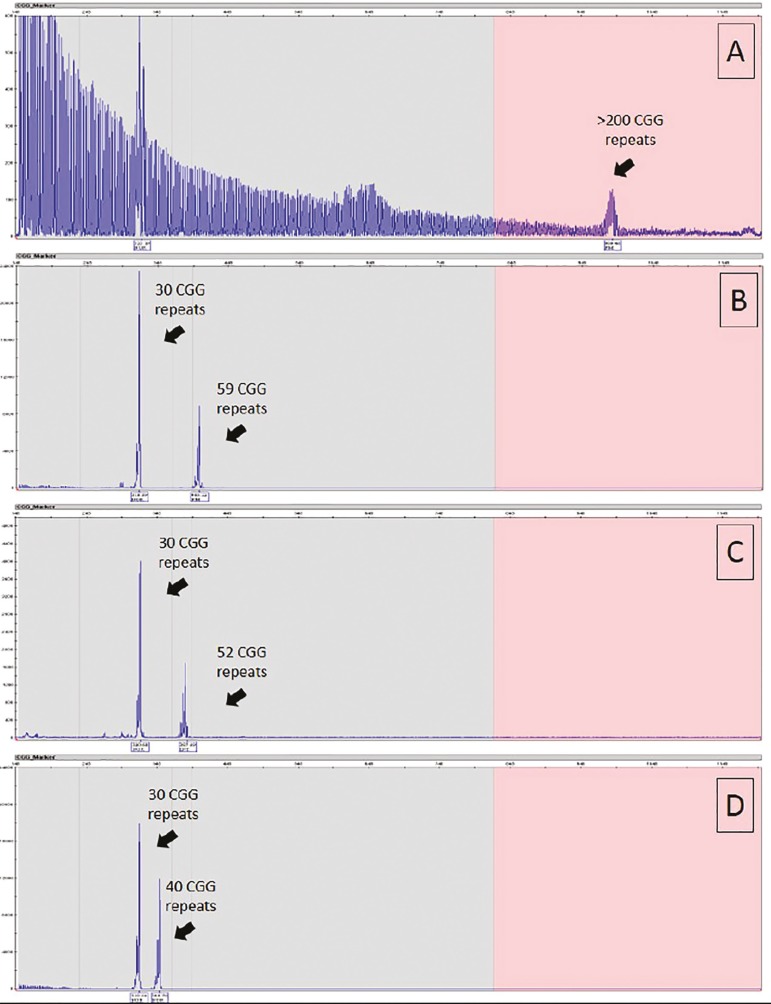
Fragile X testing. The number of CGG repeats was determined by Tripled Repeat Primed PCR amplification of the 5' untranslated region of the FMR1 gene followed by capillary electrophoresis (AmplideX FMR1 PCR Kit, Asuragen, Austin, TX, USA). (A): Patient with a full mutation, confirming the diagnosis of Fragile X syndrome; (B): Patient with two alleles with 30 and 59 CGG repeats, suggestive of premutation; (C): Patient with two alleles with 30 and 52 CGG repeats, which corresponds to an “intermediate allele” carrier; (D) Patient with two normal alleles with 30 and 40 CGG repeats